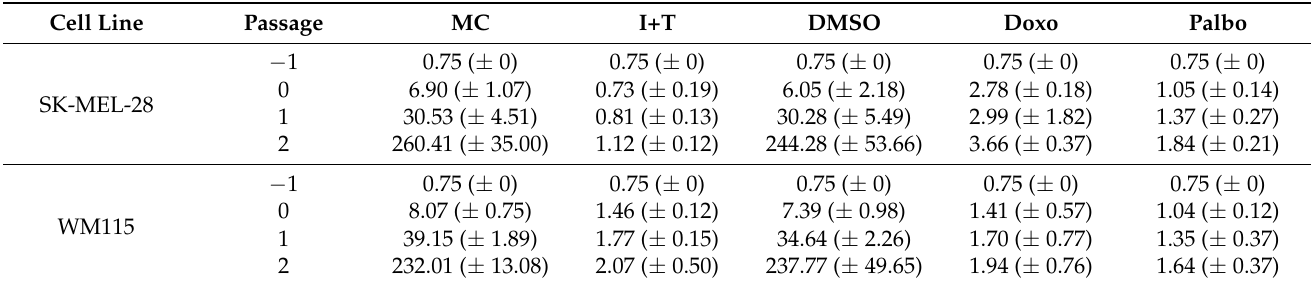
Table 1. Cell numbers ( × 10 6 ) that were counted and calculated in the growth arrest assay (Figure 2a,b) for each condition. The mean value ( ± s.d.) is